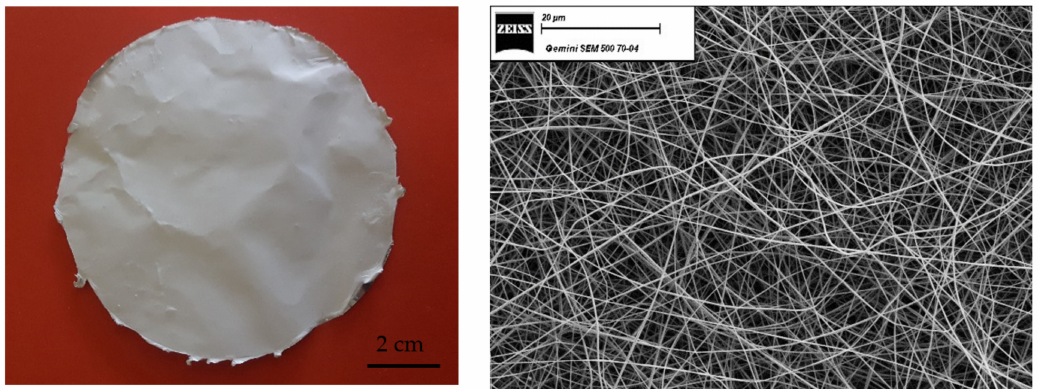
Figure 1. Optical and SEM micrographs (magnification 1000 × ) of the PPSU electrospun